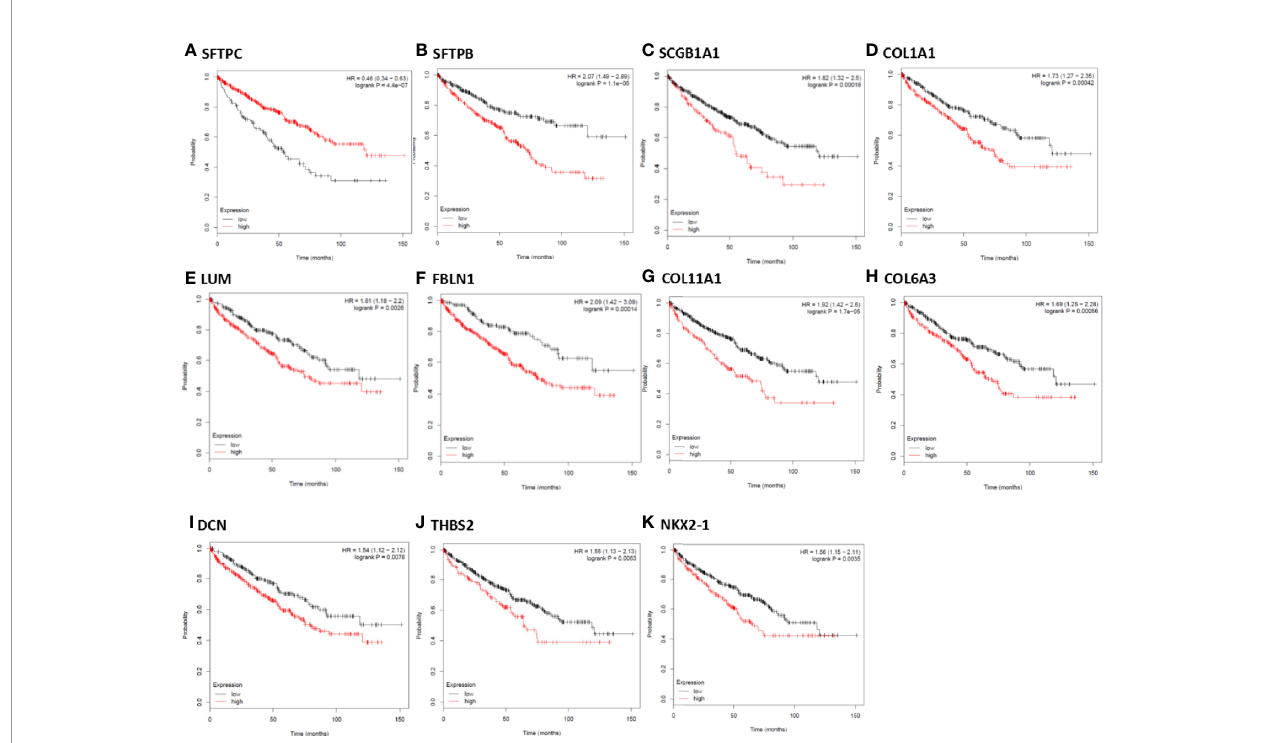
FIGURE 5 | Kaplan-Meier survival analysis for the correlation of 11 hub genes with overall survival of the patients with ccRCC. The vertical coordinate represents the survival probability of ccRCC patients. The red curve represents ccRCC patients with up-regulation of genes, while the black curve represents ccRCC patients with down-regulation of genes.